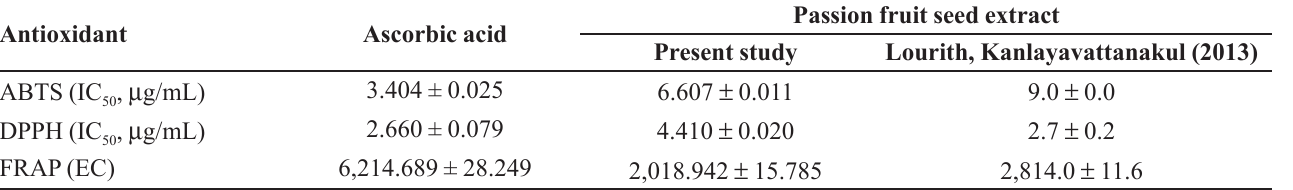
TABLE III - Antioxidant activities of the passion fruit seed extract Antioxidant